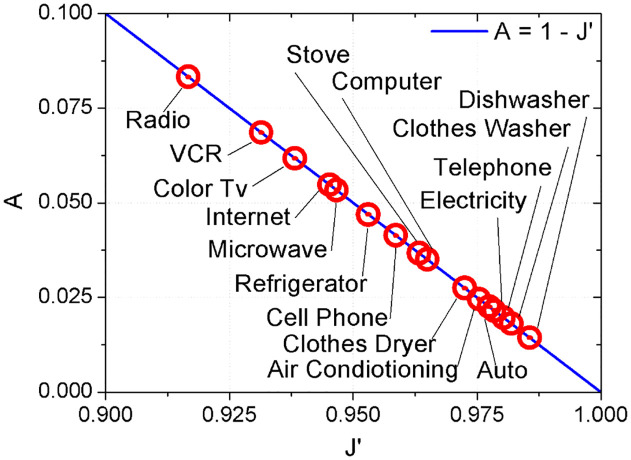
Best-fit parameters of the model represented in the A
vs
J′ plane.Each point (symbol ⊙) represents the pair of values of the best fit of the empirical data with the analytical solution of the model. The solid line (blue) corresponds to the A = 1 − J′ relation. ω ≃ 1 for all the technologies.